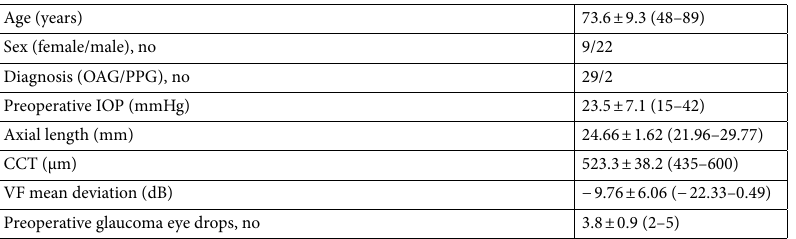
Table 1. Demographic and clinical characteristics of the patients (N = 31). Data (except for sex and diagnosis) are presented as mean ± standard deviation with the minimum and maximum values in parentheses. CCT, central corneal thickness; IOP, intraocular pressure; OAG, open-angle glaucoma; PPG, preperimetric glaucoma; VF, visual field.